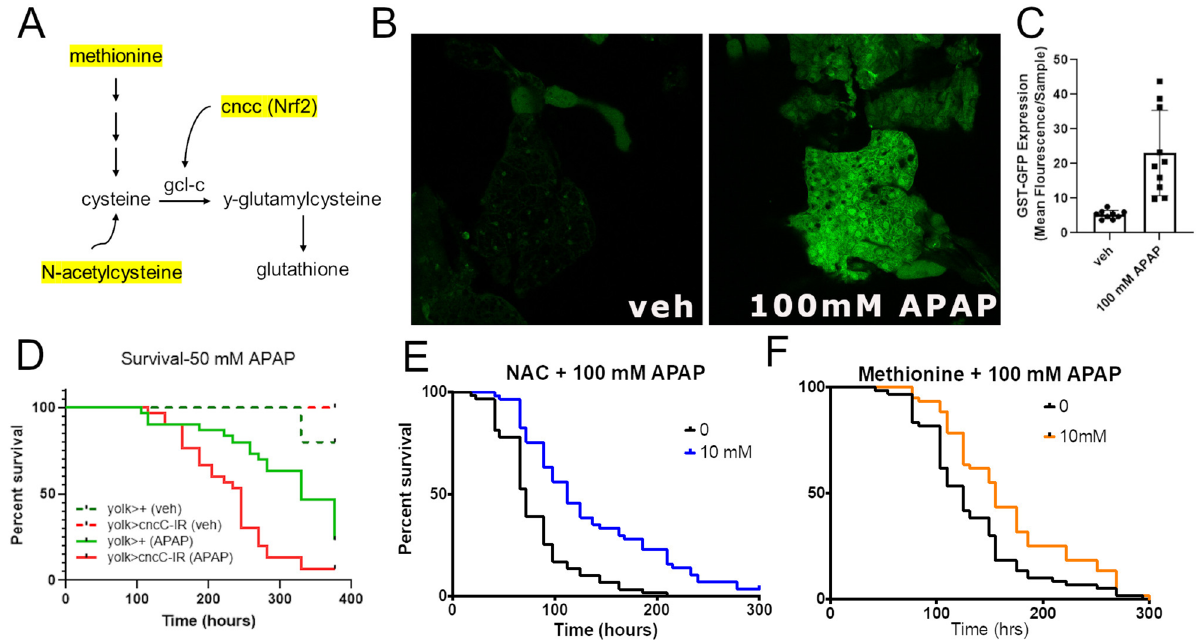
Figure 5. Genetic and pharmacologic modification of antioxidant response pathways alter APAP toxicity in Drosophila . ( A ) Schematic representation of glutathione generation in metazoans, highlighting the role of Nrf2/ CncC, N-acetylcystein, and methione (in yellow). ( B ) Representative images and ( C ) quantification of mean GFP fluorescence in control and 100 mM APAP treated ARE-GST-GFP animals. ( D ) Survival of vehicle treated and 50 mM APAP-treated control and experimental animals, in which dNrf2 knockout (cnccIR) is depleted in the Drosophila fat body using the fat body driver Yolk-Gal4. Log-Rank test p < 0.0001, n = 60. ( E ) Effect of 100 mM N-acetylcysteine supplementation on APAP toxicity. ( F ) Effect of 10 mM Methionine supplementation of APAP toxicity. Log-Rank test p < 0.0001, n =